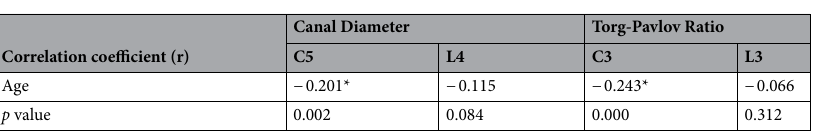
Correlation coefficient